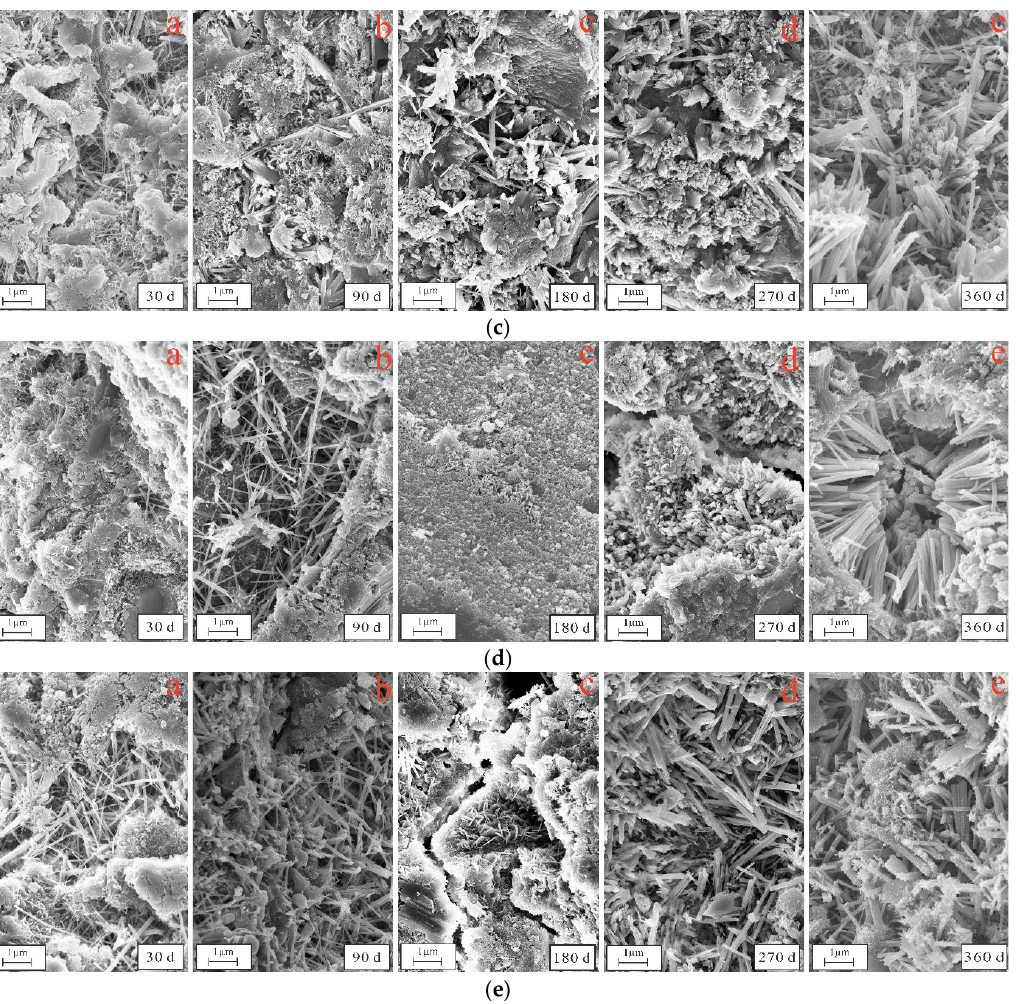
Figure 9. SEM images of samples in different erosion solutions: ( a ) C; ( b ) CS0.2-M; ( c ) CS0.5-M; ( d )